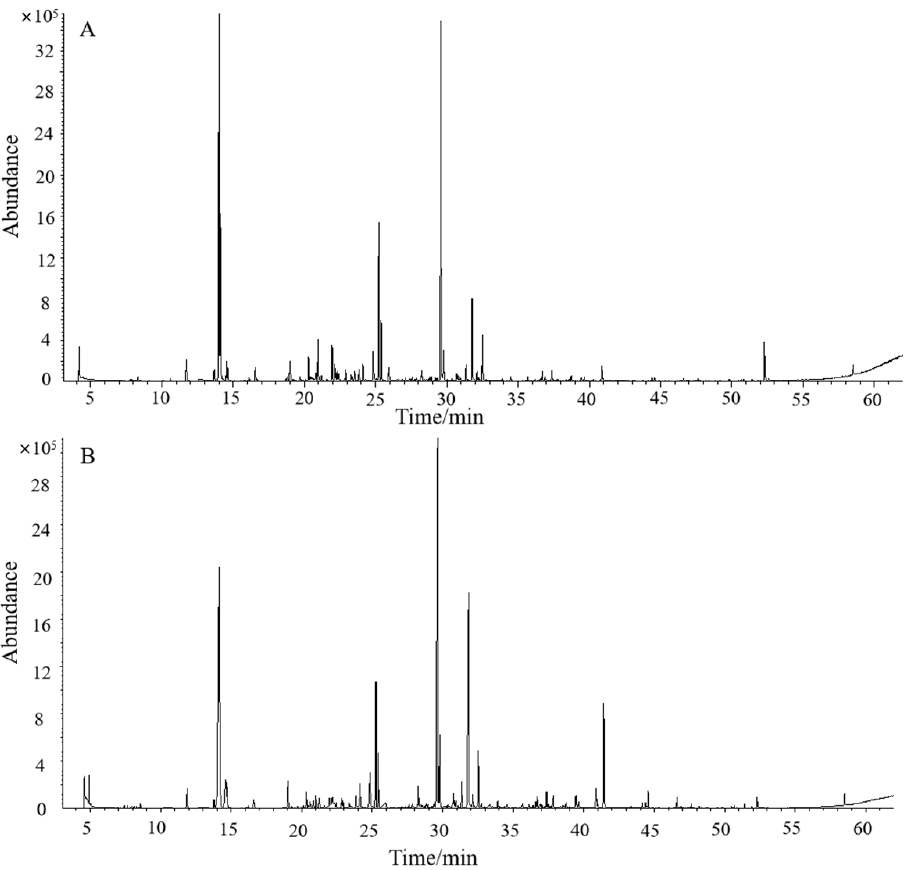
Figure 1. GC-MS total ion chromatogram of volatile compounds in tea leaves ( A ) healthy; ( B ) in- fected.